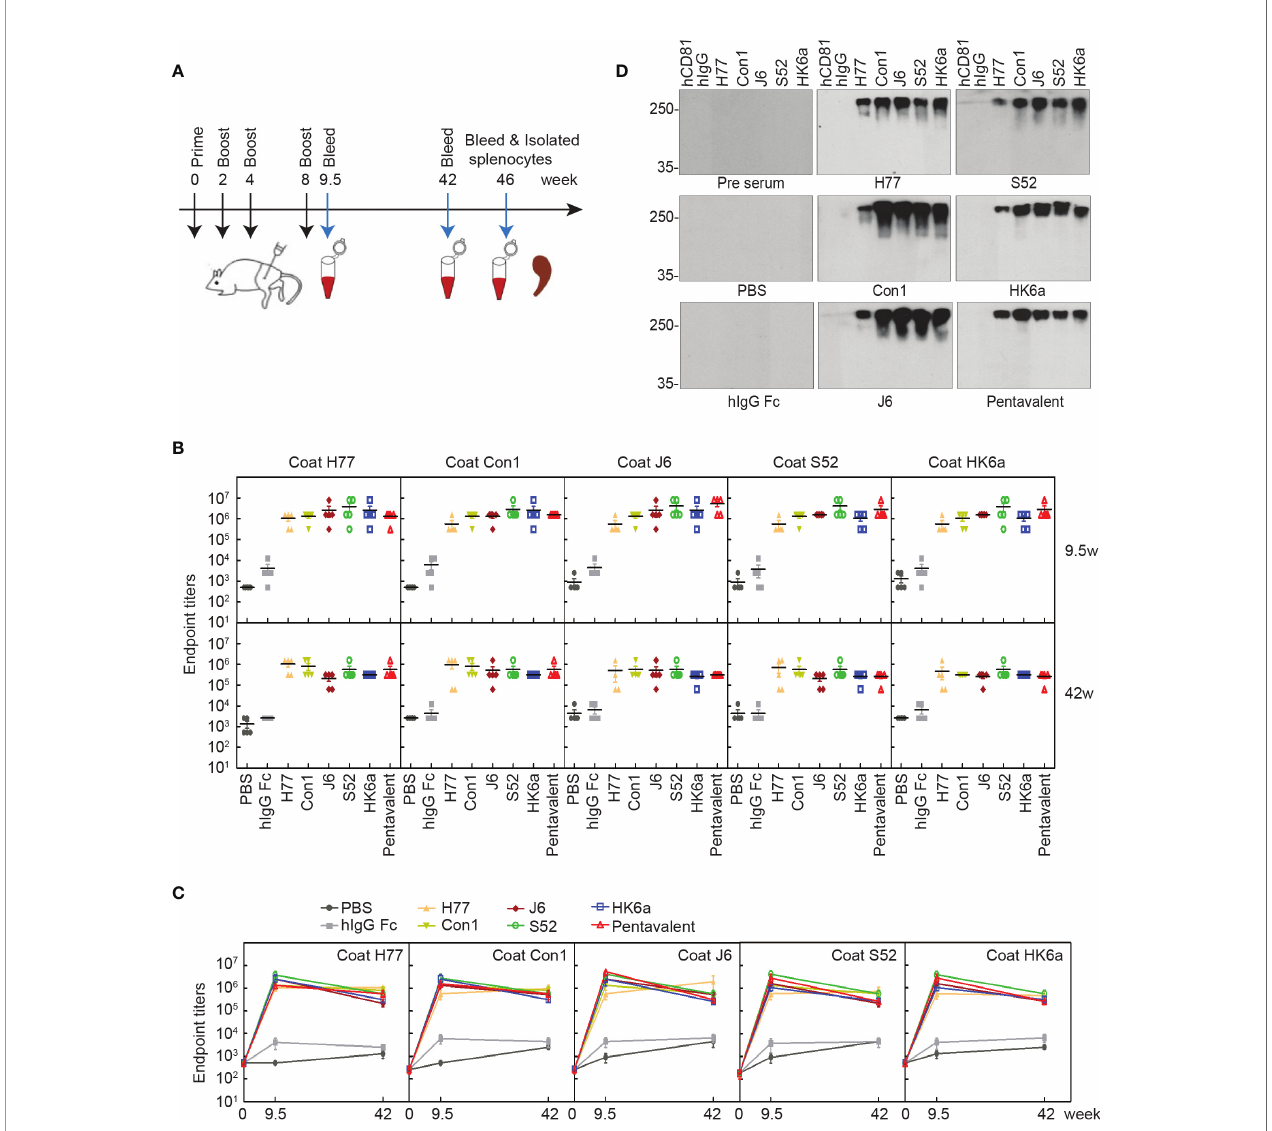
FIGURE 5 | Characterization of induced antibody in mice. (A) Schematic representation of immunization schedule. BALB/c mice (n = 10 per group) were immunized intramuscularly at weeks 0, 2, 4, and 8, and sera were collected at weeks 9.5, 42 and 46. (B) Kinetics of Fc-E1E2-speci fi c antibody titers. The speci fi c serum titers of each group in week 9.5 and week 42, respectively. The serum titers at weeks 0, 9.5 and 42 (n = 5 per group) were measured by ELISA. The data are expressed as the mean ± SEM of the endpoint titers for each group. (C) Time point curve was plotted according to panel (B) . (D) Native western blotting analysis of immunized sera speci fi city to native Fc-E1E2. Immunized sera per group were diluted at 1:100 as the primary antibody, followed by donkey anti-mouse secondary antibody. Data are shown as a representative result from three independent